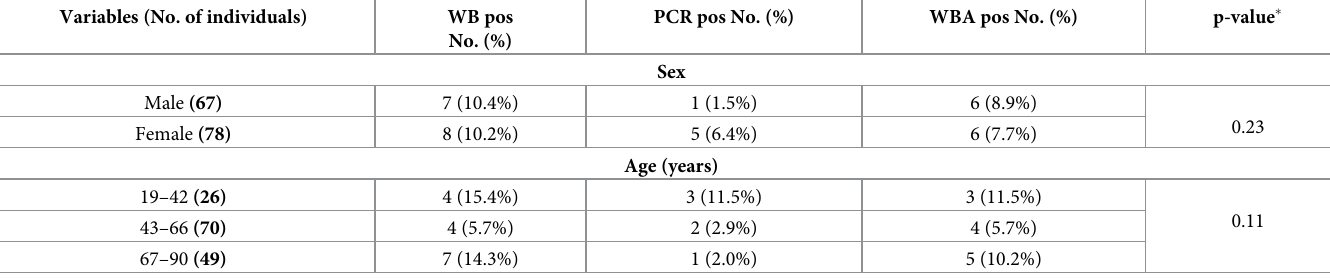
Table 2. Demographic characteristics of 145 volunteers residing in Pianoro municipality, Bologna Province (northeastern Italy). Variables (No. of individuals)